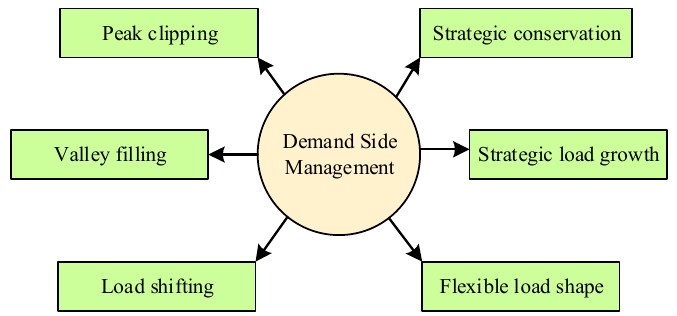
Figure 1. Basic Demand Side Management approaches.